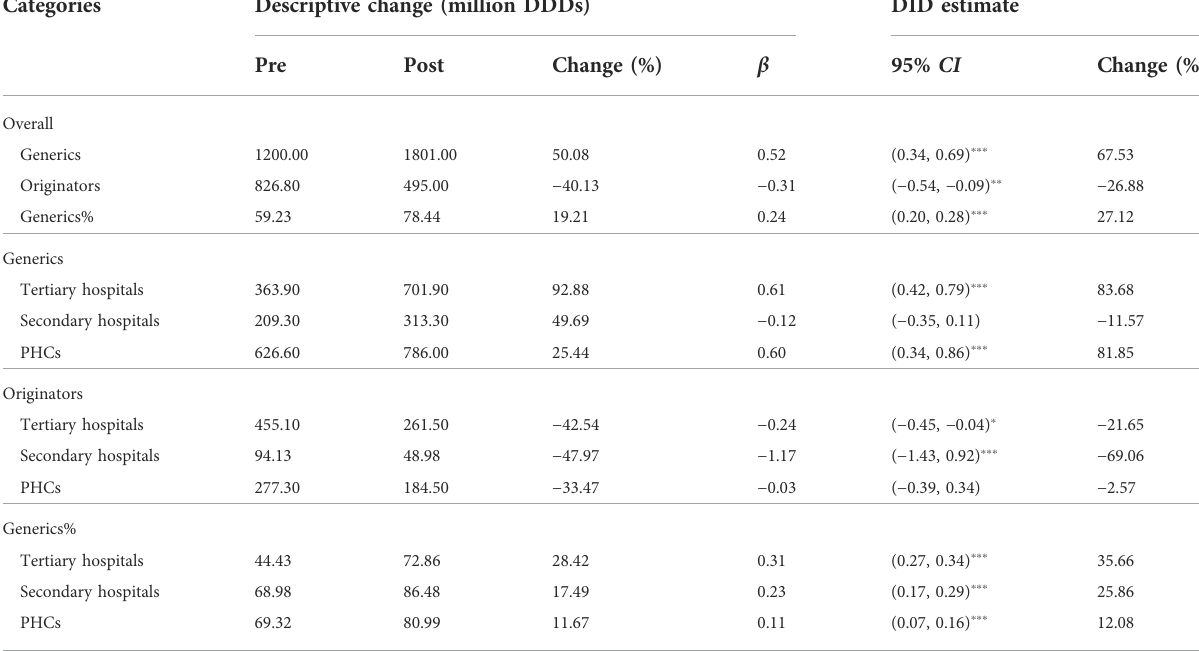
TABLE 2 Impact of the “ 4 + 7 ” pilot on monthly volumes of generic or original drugs, strati fi ed by healthcare